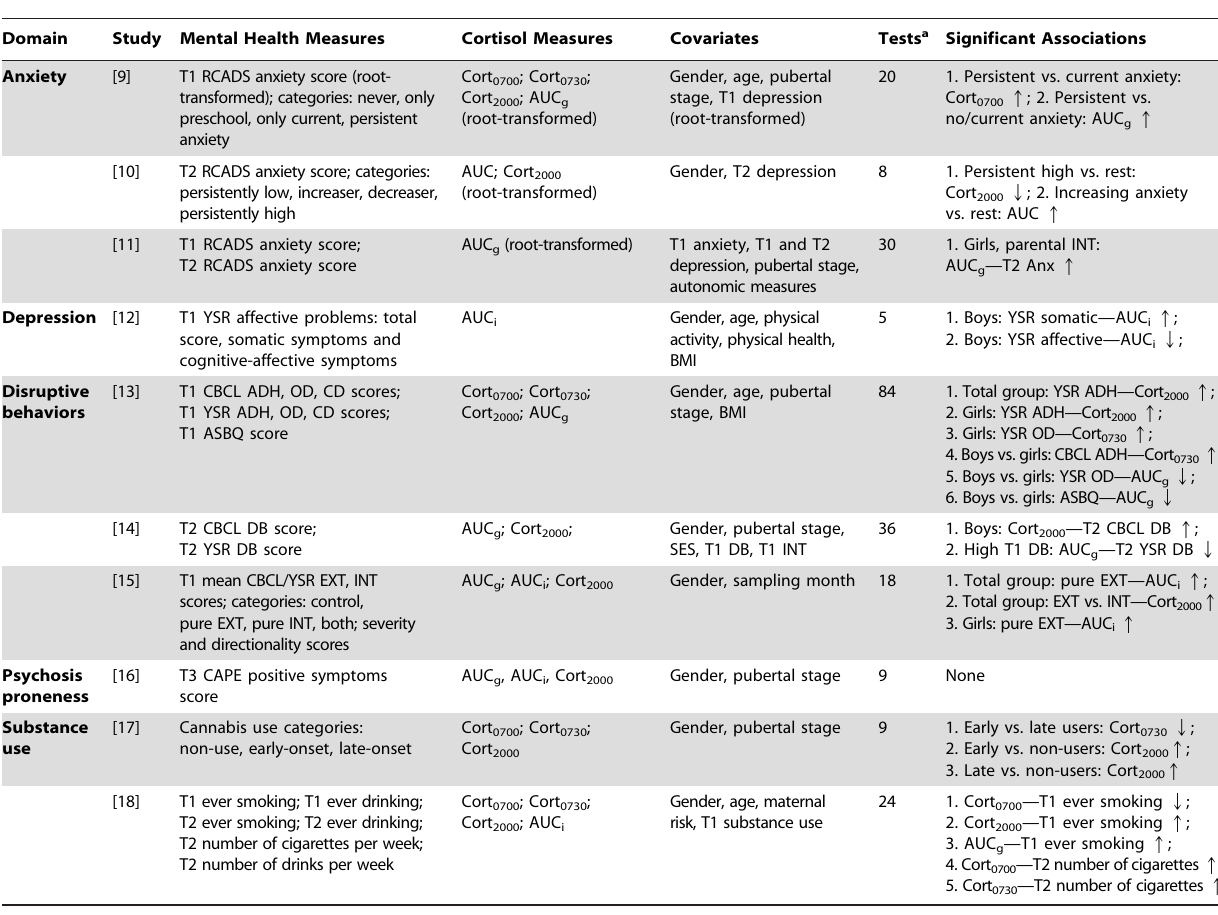
Table 1. Publications on associations between (basal) cortisol measures and psychopathology in TRAILS.